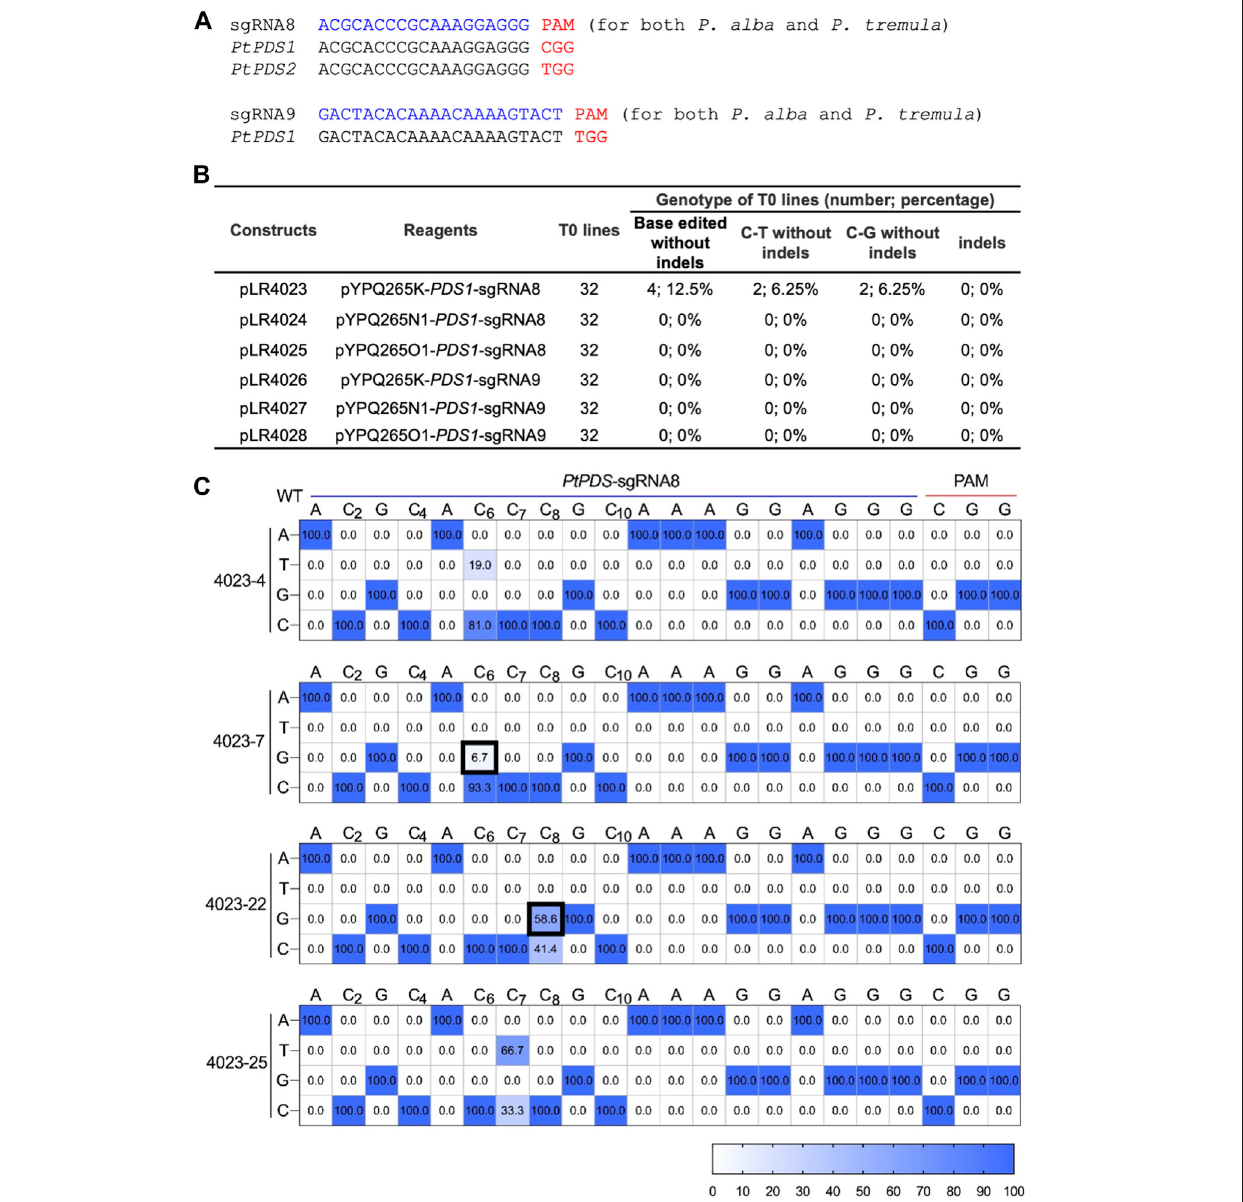
Frontiers in Genome Editing |